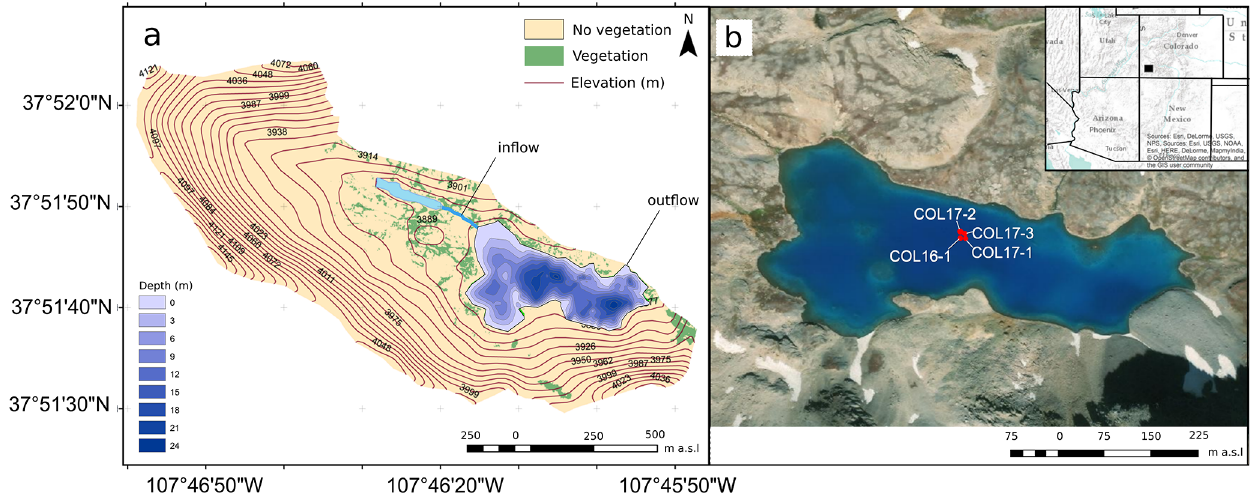
Figure 1. Columbine Lake and its catchment showing the (a) bathymetry and (b) coring location (red circles) in southwestern Colorado (black rectangle in inset map). Vegetation extent for the year 2017 is based on Arcusa et al. (2019a). Image credit: Esri, DigitalGlobe, GeoEye, Earthstar Geographics, CNES/Airbus DS, USDA, USGS, AeroGRID, IGN, and the GIS user